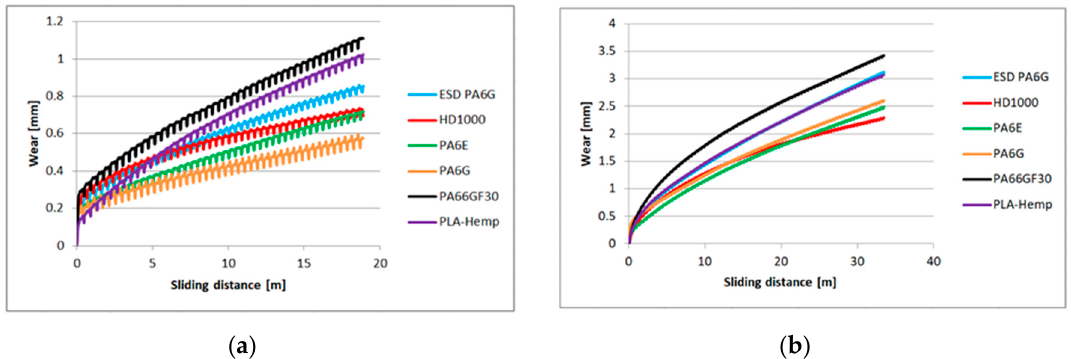
Figure 6. The relation between the wear and sliding distance for several polymer types on P150 abrasive clothing: ( a ) lowest applied pv , ( b ) highest applied pv .